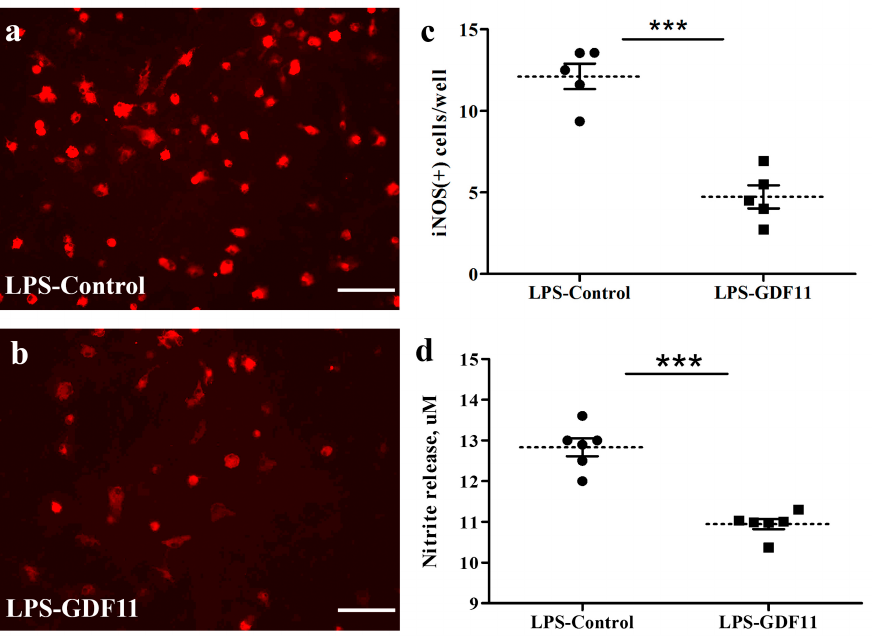
Figure 5. GDF11 reduced LPS stimulation in neuron–glial cultures. ( a , b ) iNOS-IR cells in control or GDF11-treated LPS-stimulated cultures, respectively. ( c ) Quantification of iNOS-IR cells (iNOS (+) numbers per 3.56 × 10 − 3 cm 2 ) in LPS- stimulated cultures of ( a , b ). Notably, GDF11-treated cultures significantly reduced LPS-induced iNOS (+) numbers ( p < 0.001). ( d ) LPS treatment induced nitrite release to medium in control or GDF11-treated cultures. GDF11-treated cultures significantly reduced LPS-induced nitrite release into the medium ( p < 0.001). The results are reported as mean ± SEM in each group from three independent experiments. *** p < 0.001 indicates a significant difference between the LPS control and LPS treatment groups using unpaired Student t -test. Magnification: 200 × . Scale bar: 100 µ m.